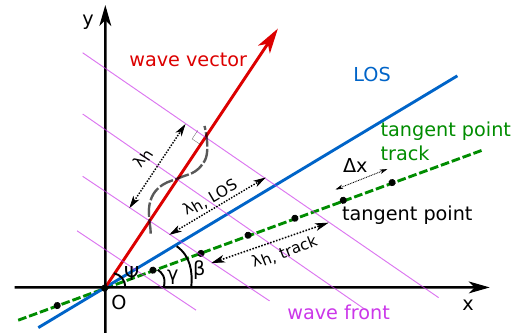
Figure 8. Combination of the satellite’s viewing geometry and the geometry of the observed GW. One LOS (blue line) is shown for the tangent point at the origin. The horizontal wavelength along LOS ( λ h, LOS ) can be calculated knowing the true horizontal wavelength ( λ h ) and angles β and ψ . The projection of horizontal wavelength on tangent-point track can be calculated knowing the true horizontal wavelength ( λ h ) and angles γ and ψ . For details, see